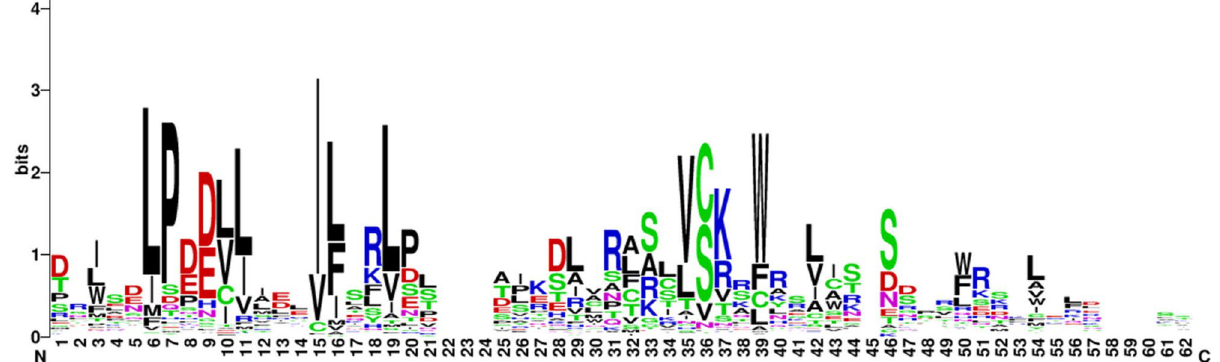
Figure 3. The conservation of SaFbox amino acid residues were analyzed. The numbers on the x-axis indicate amino acid positions. The size of the amino acid on the y-axis indicates the number of times the amino acid appears in a particular